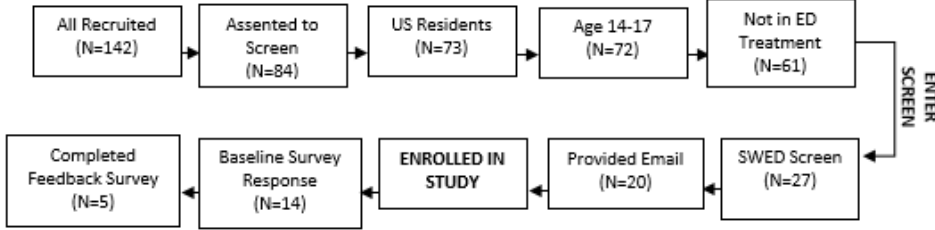
Figure 1. Participants eligible after each online screening step—Discovery Group.